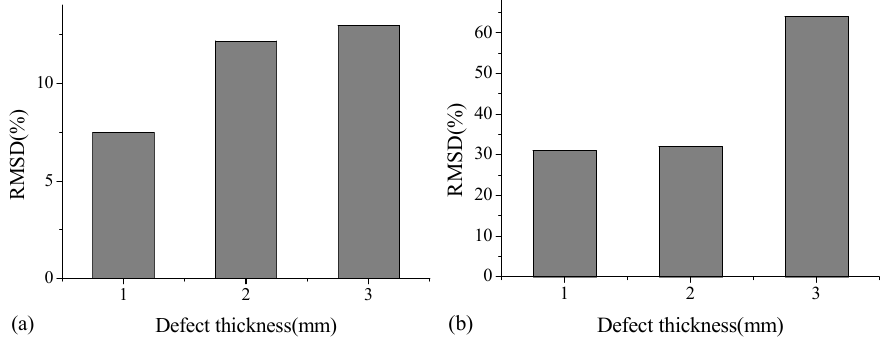
Figure 8. RMSD values of B-type specimen at the frequency ranges of ( a ) 6000–8000 kHz and ( b ) 10,000–12,000 kHz.